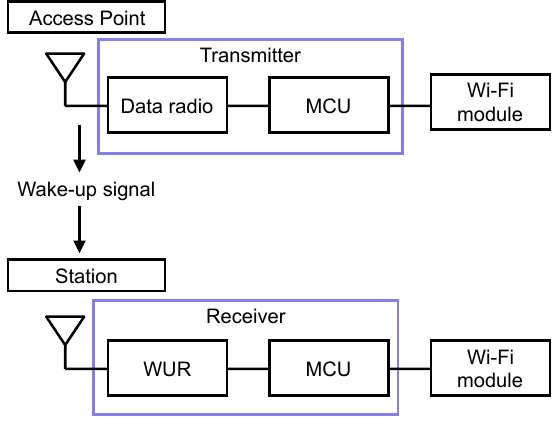
Figure 4. Overview of LDWuR for Wi-Fi power savings.